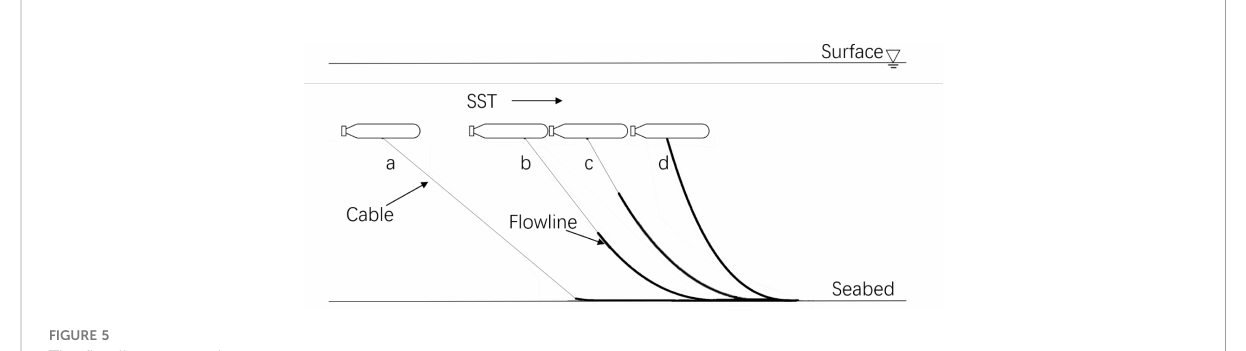
FIGURE 5 The fl owline connecting